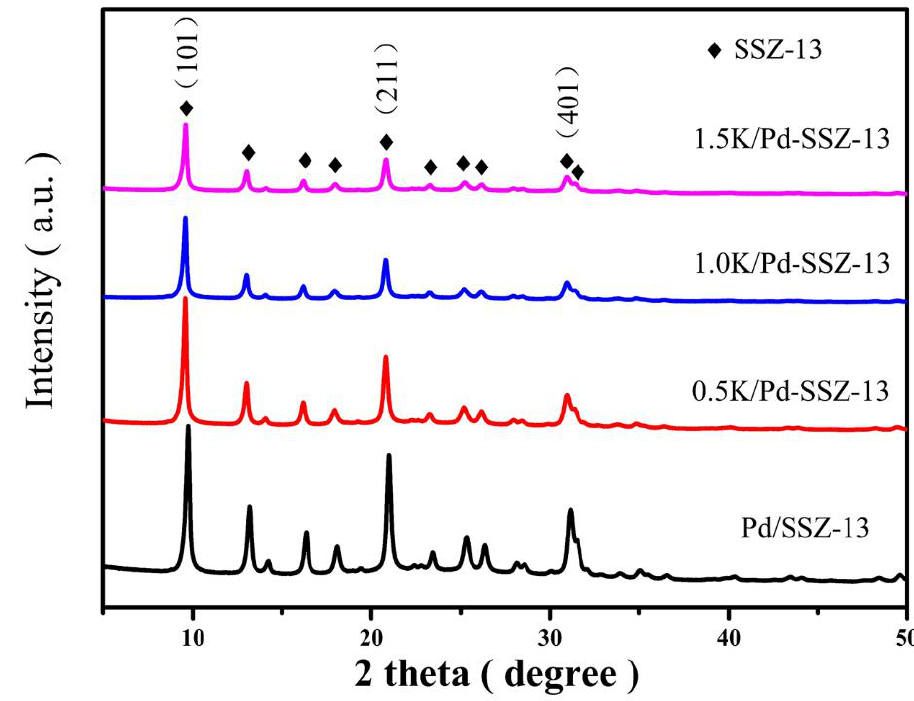
Figure 1. XRD patterns of Pd/SSZ-13 and K-deactivated samples.